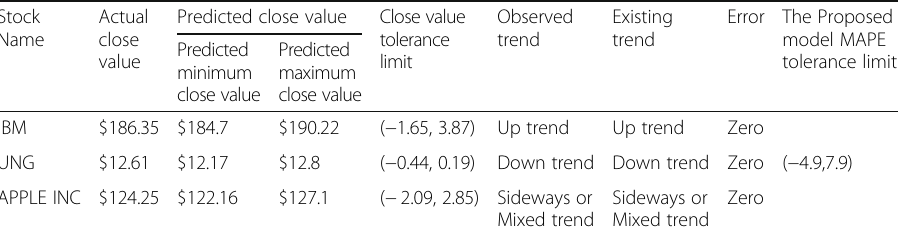
Table 6 Sample data for actual close value, predicted close value, tolerance, observed trend, existing trend and error for various stocks using Markov chain and fuzzy interrelated